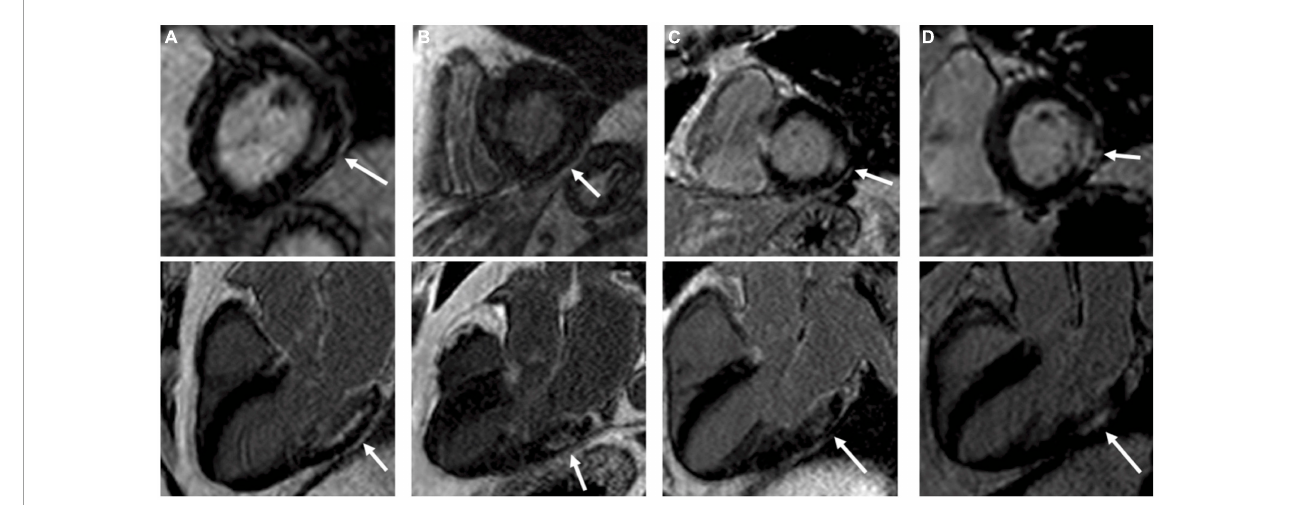
FIGURE4 Four type 2 diabetes mellitus patients (A–D) with typical non-ischemic late gadolinium enhancement (LGE) lesions with left ventricular short-axis and long-axis images. Non-ischemic lesions are located mid-myocardial, basal and lateral or inferolateral. In segments with non-ischemic LGE lesions, the myocardium remains thick. Adapted from Bojer et al. with permission